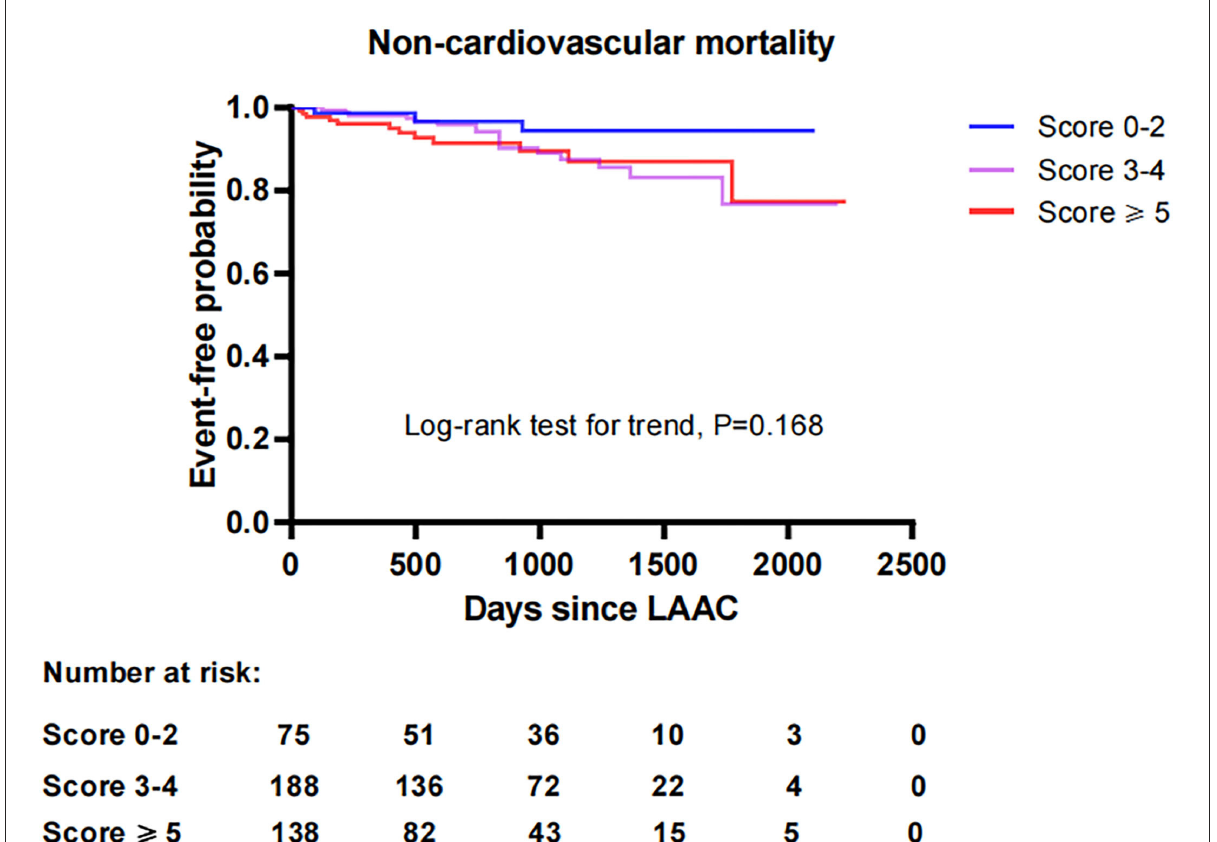
FIGURE3 Comparison of the cumulative ratio of freedom from non-cardiovascular mortality in different subgroups. LAAC, left atrial appendage